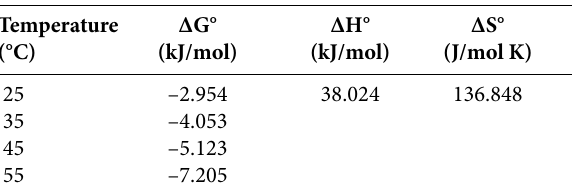
Table 5. Thermodynamic parameters for P ion sorption using Mn- Fe